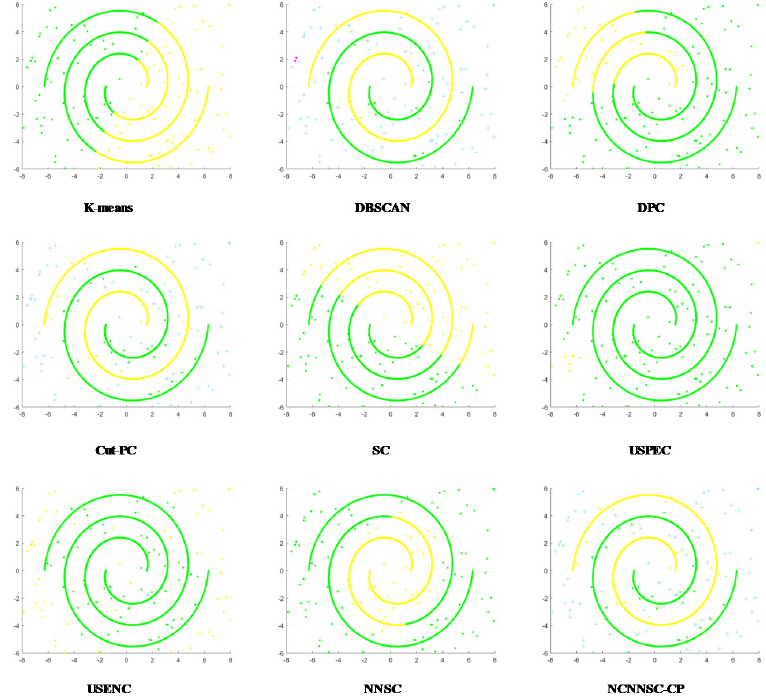
Figure 11. The results of 9 clustering algorithms in D6.